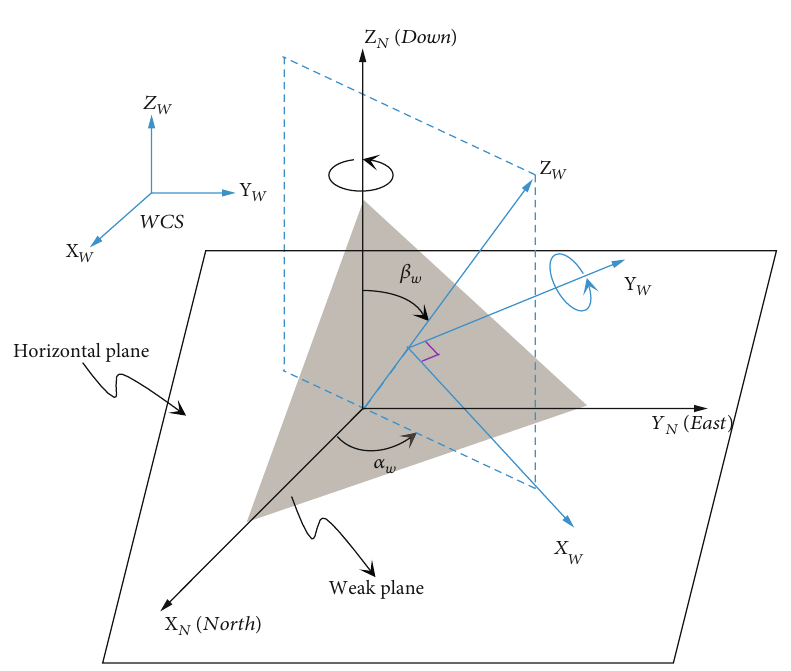
Figure 2: The relationship between GCS and